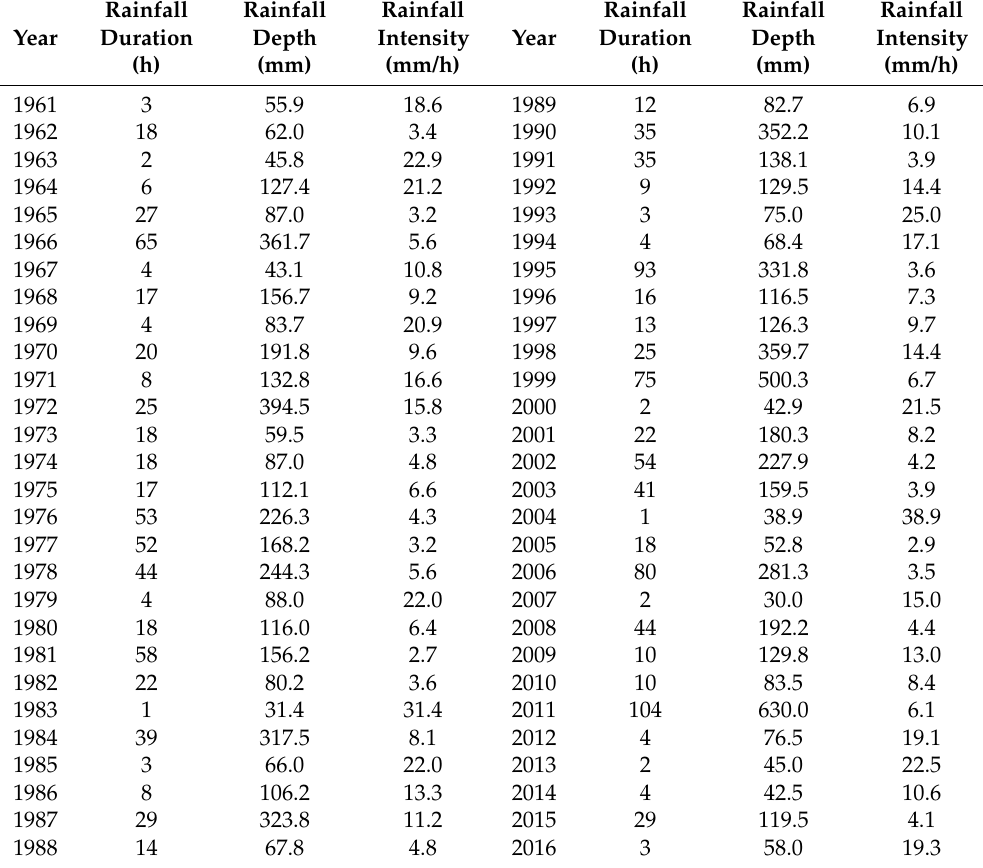
Table 1. Characteristics of the annual maximum rainfall events collected from 1961 to 2016 in Seoul,